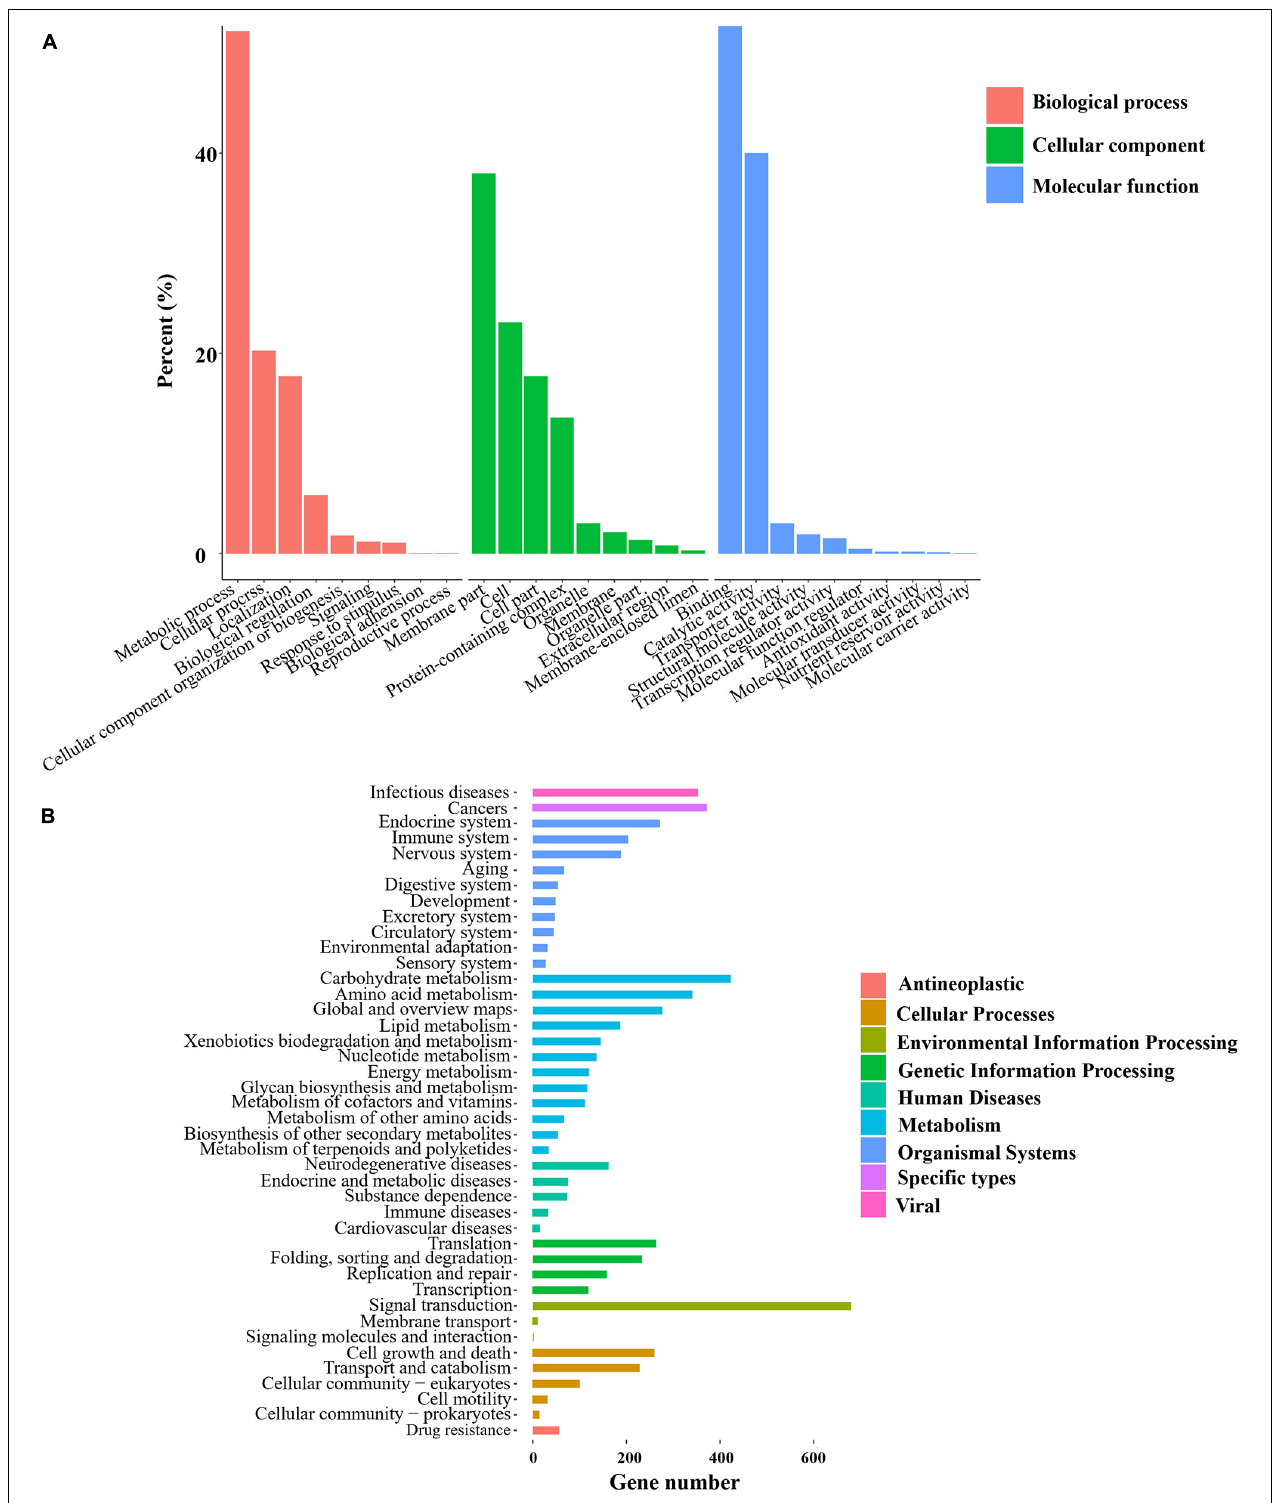
FIGURE 3 | Statistics of GO and KEGG annotation results. (A) GO enrichment analysis of the P. tuber-regium transcriptome. The Y -axis indicates the percentage of a specific category. (B) KEGG enrichment analysis of pathways of the P. tuber-regium transcriptome. The X-axis indicates the number of genes in each function.